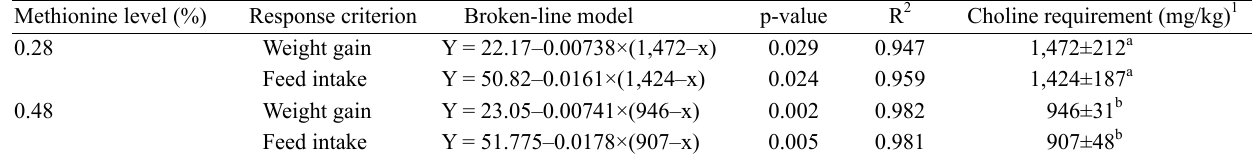
Table 3. Choline requirements for weight gain and feed intake at different supplemental methionine levels according to